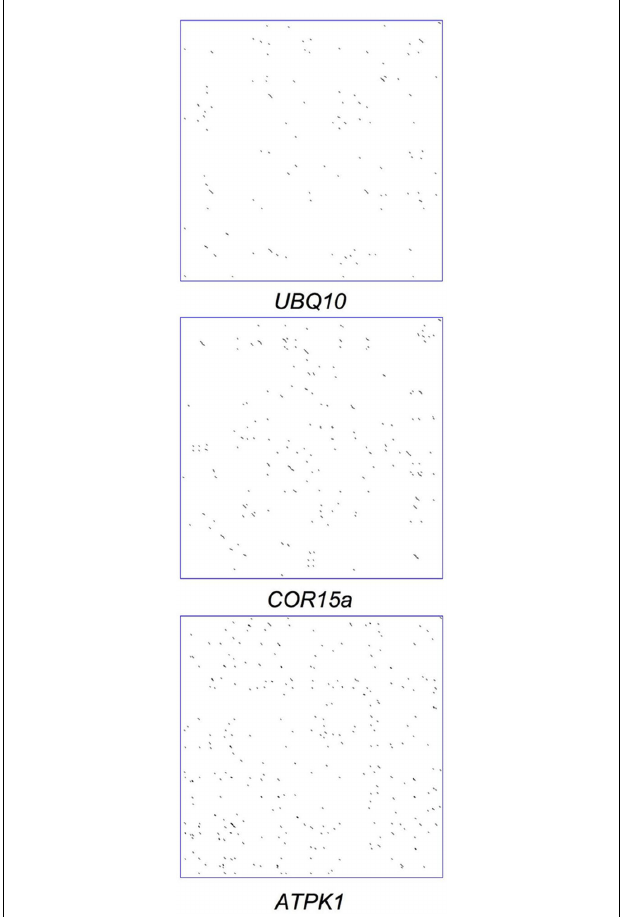
FIGURE 3 | Dot plots of introns. The sequence of each intron ( x axis) compared to its reverse complement ( y axis), with dots indicating the position of each match of 5nt in